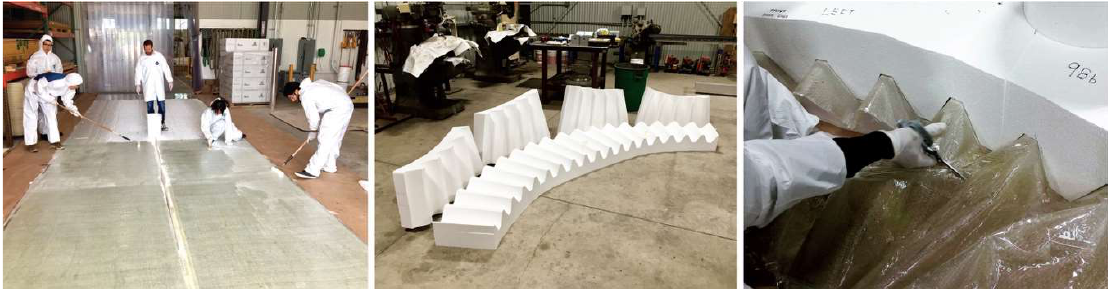
Figure 18. The sandwich core is made from a thin layer of glass-fiber reinforced plastic (GFRP) and pressed into form using a Styrofoam mold that was custom-made on a 4-axis hotwire machine.